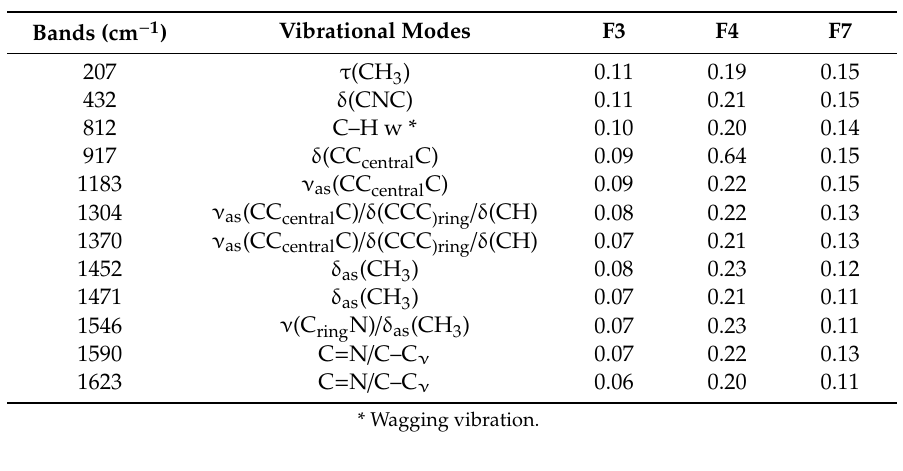
Table 7. Enhancement factors acquired for the bands of 10 − 4 crystal violet on supports F3, F4 and F7 and the main vibrational modes these bands belong to.